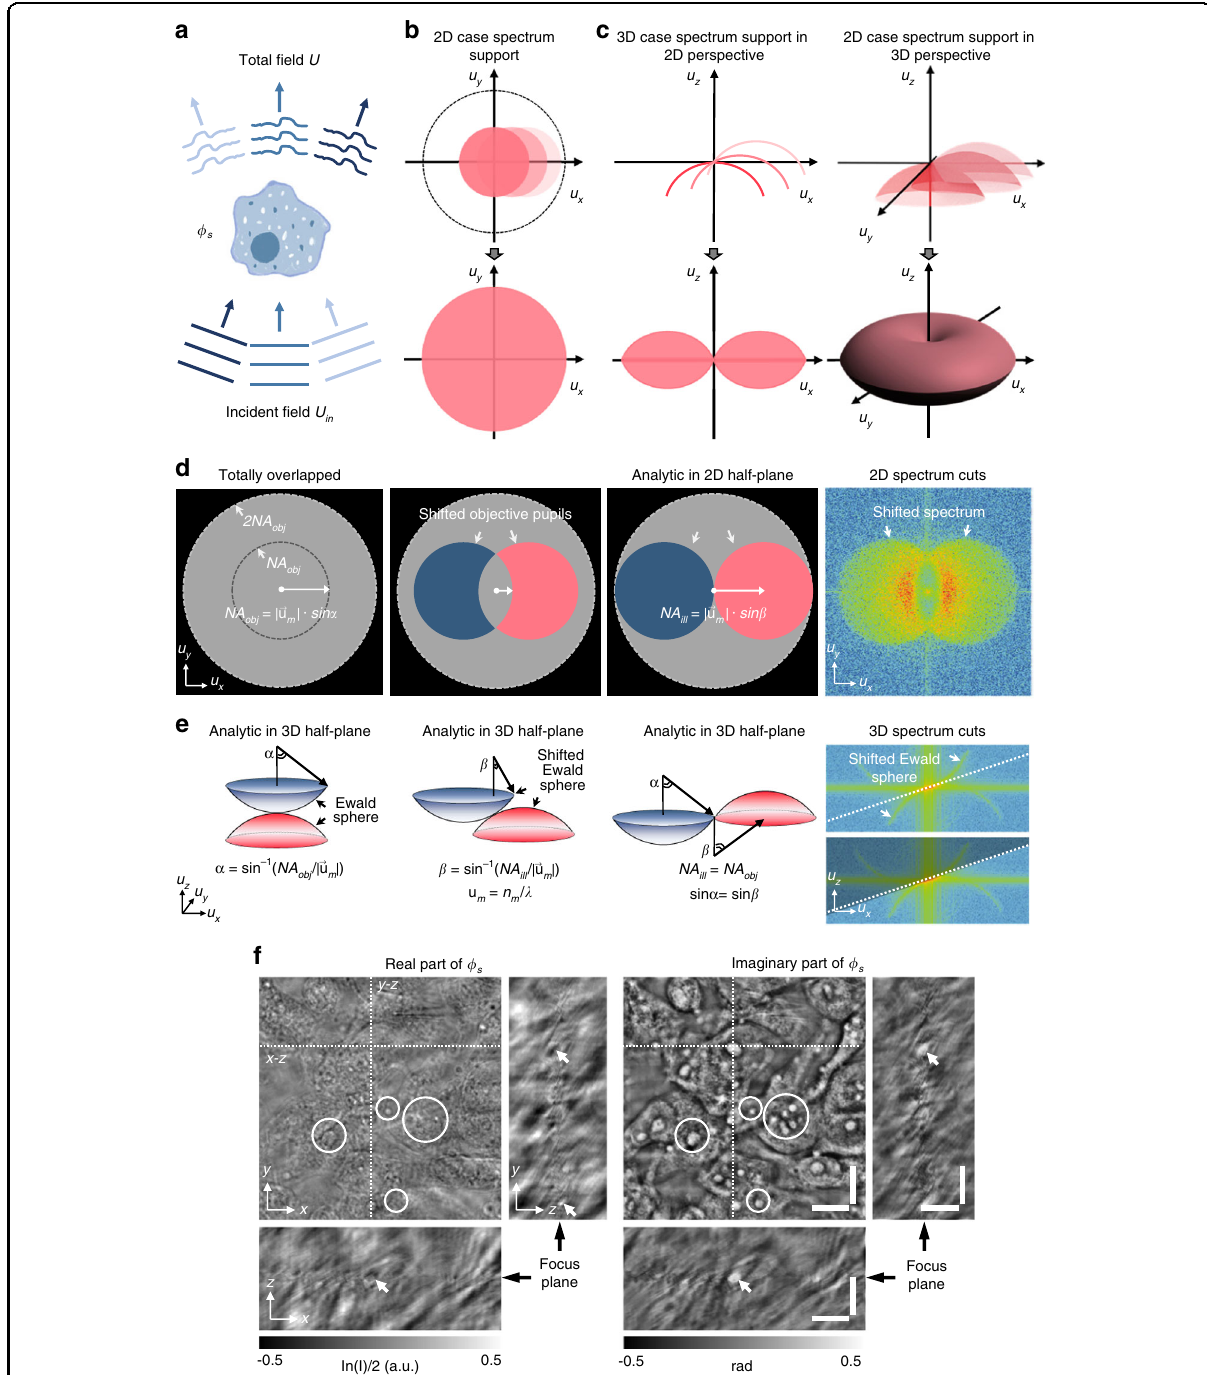
Fig. 1 Illustration of the uni fi ed framework for 2D and 3D optical transfer functions and experimental demonstrations of 3D imaginary part recovery taking an example of unstained MCF-7 cells. a Object ϕ s is illuminated by the plane waves from different directions, and the total fi eld U ( r ) results from the interference between the scattered fi eld U fi elds U s ( r ) and the unperturbed in ( r ). b , c Supports of frequency spectrum for the cases of 2D imaging and 3D imaging under angle-varied illuminations, and the full spectrum coverage for the complex amplitude of the 2D sample and the scattering potential of the 3D sample. d , e 2D and 3D phase transfer functions of system under different illumination conditions and experimental captured 2D and 3D frequency spectrum cuts. f Phase (imaginary) component of the 3D complex function is recovered from the 3D logarithm intensity stack (real part) via space-domain Kramers-Kronig relations. Scale bars: 10